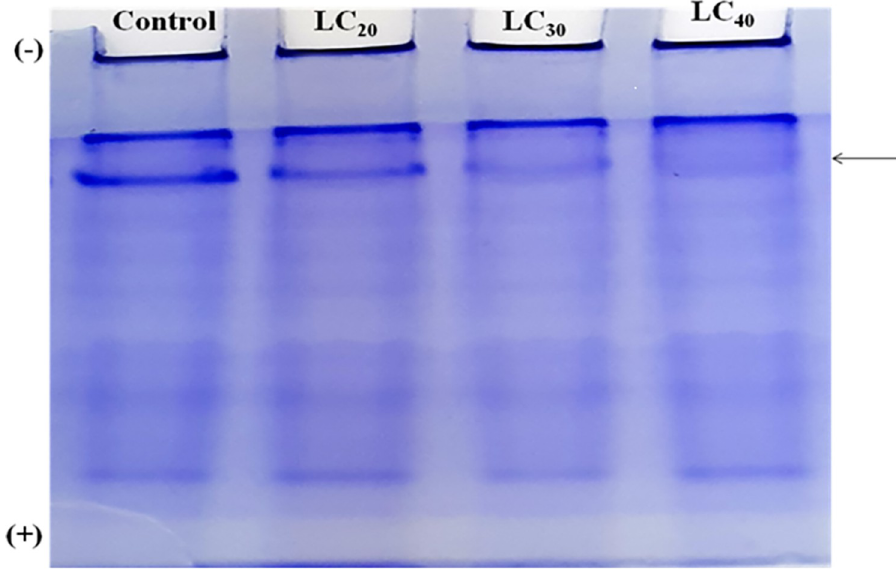
Fig 1. Qualitative analysis of total protein in native PAGE, of T . castaneum adult after treatment with essential oil of C . Citrinus .